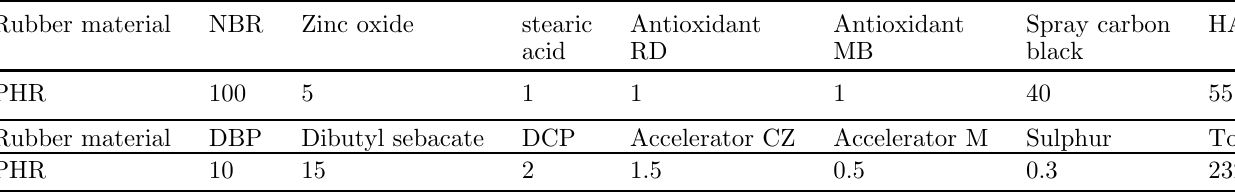
Table 2. Compound formula of pipette shaft seal ring. Rubber material